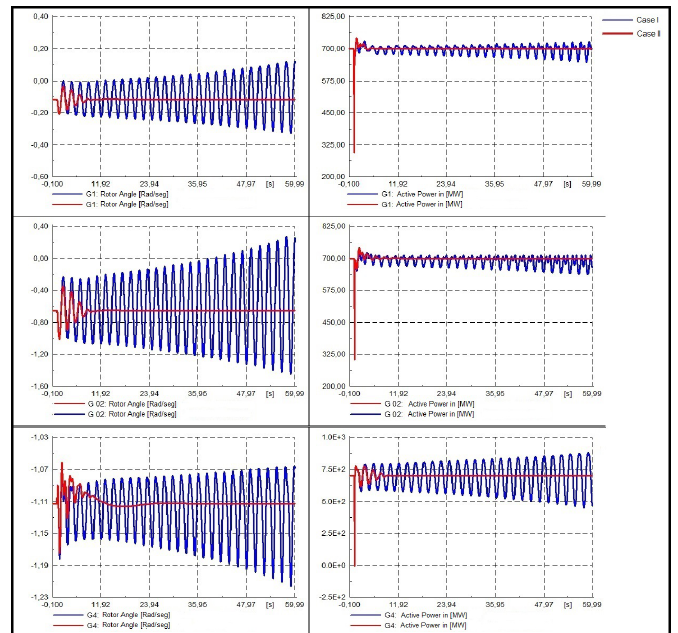
Figure 17. Rotor angle and active power [MW]-three phase fault at C1 line 7–8. 2. Three phase fault at C1 line 8–9.